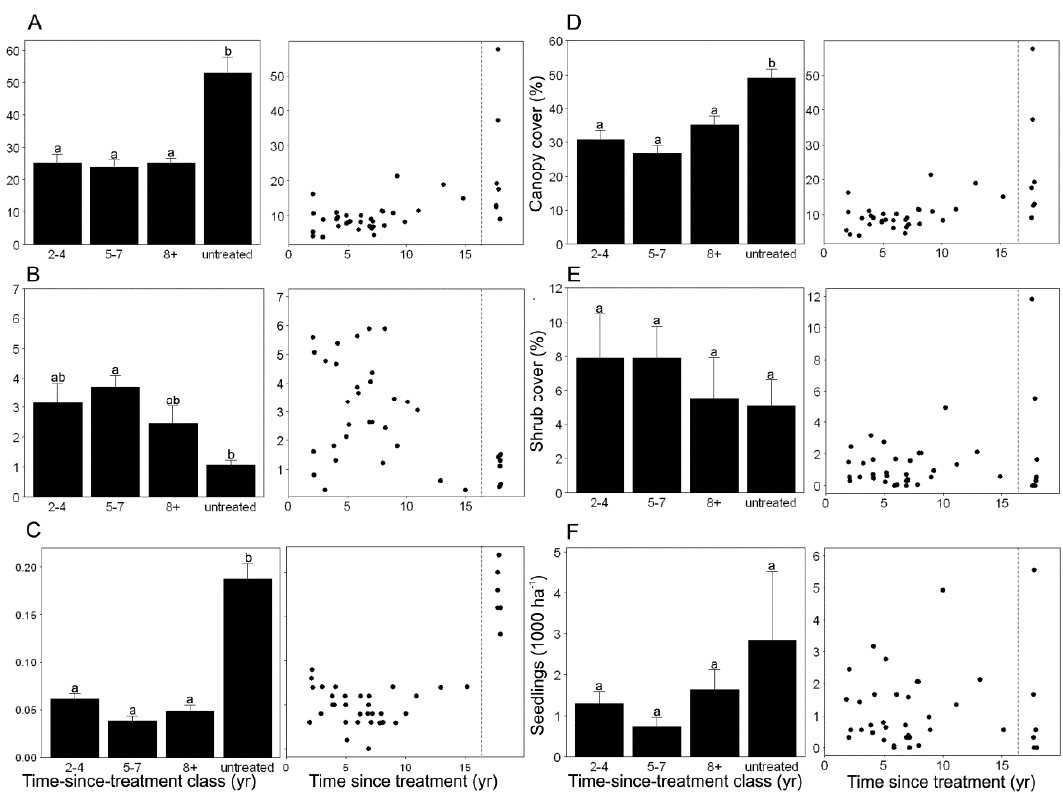
Figure 6. Eastside pine vegetation characteristics. ( A ) basal area; ( B ) canopy base height; ( C ) canopy bulk density; ( D ) canopy cover; ( E ) shrub cover; and ( F ) seedling density (all trees <2.5 cm dbh) in the eastside pine chronosequence ( n = 32) and control ( n = 7) sites. Left-hand panels show means ± SE for the three age class groups and the control group. Different letters above each bar indicate significant difference in means between groups (Tukey’s HSD multiple comparison test, p < 0.05). Right-hand panels show the relationship between time since treatment and each stand characteristic. Vertical dashed lines separate treated and untreated study